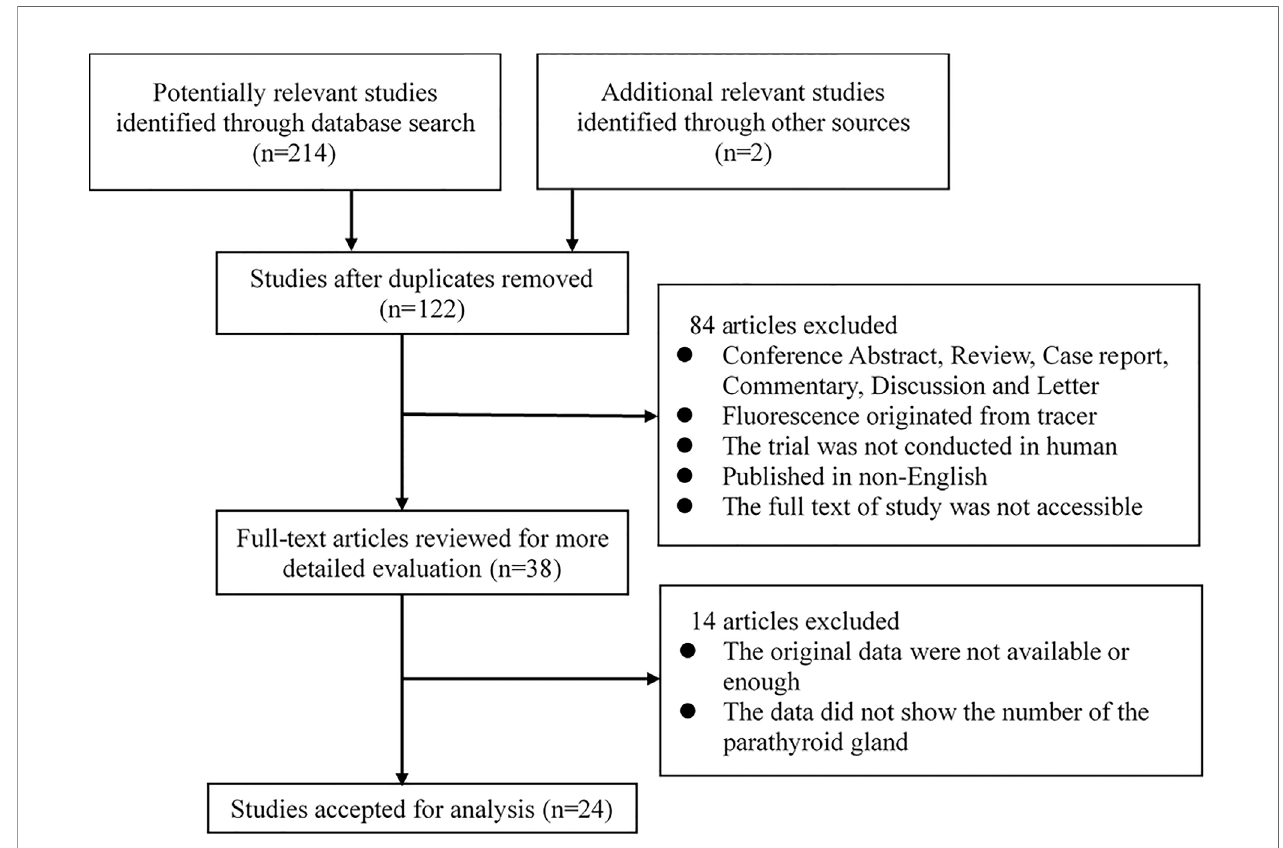
FIGURE 1 | Flow chart of study